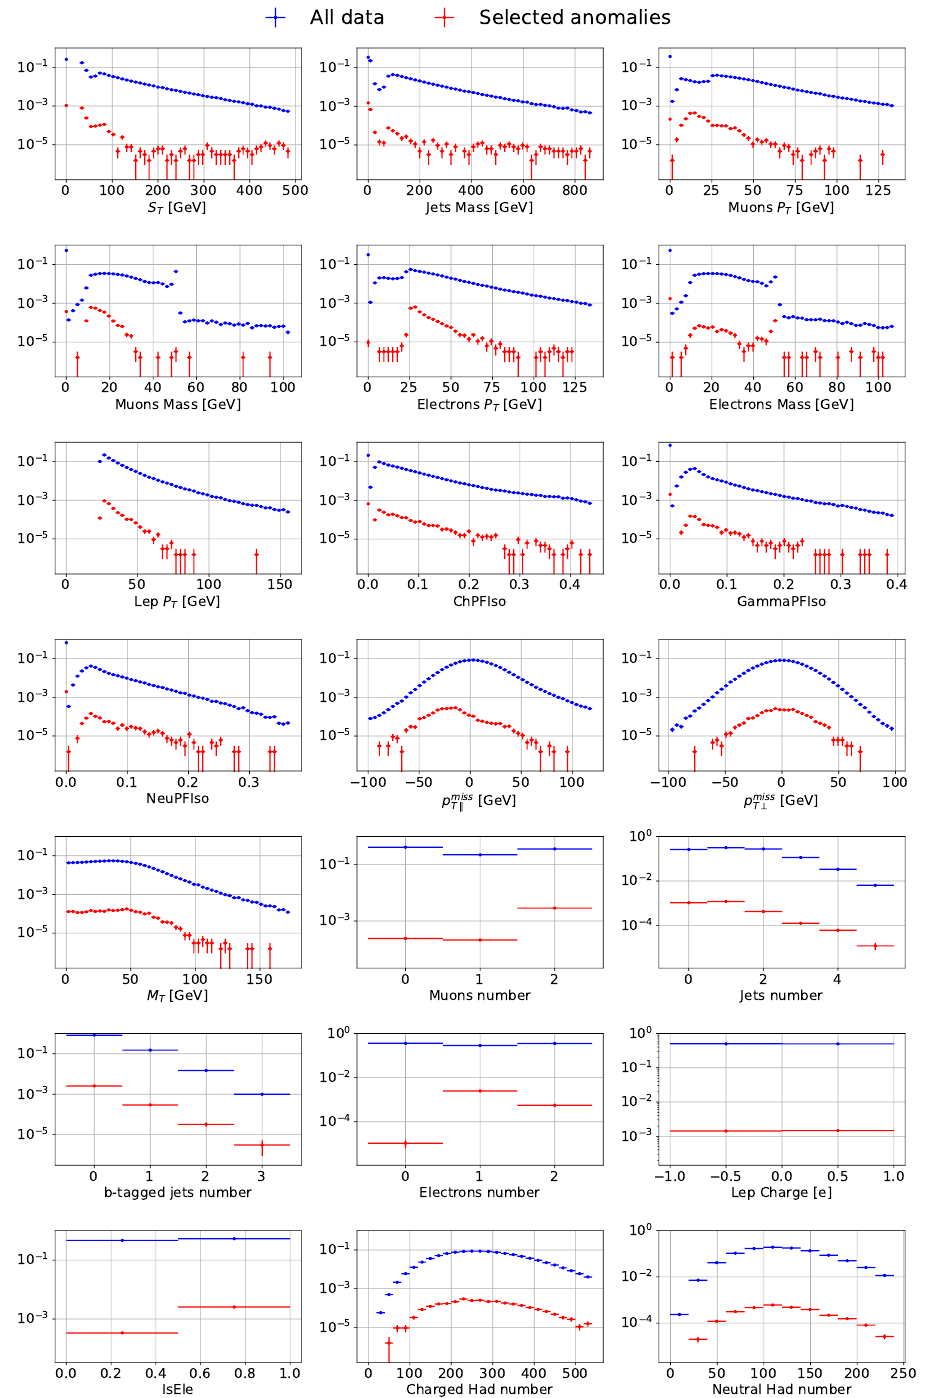
Figure 9 . Comparison between the distribution of the 21 HLF distribution for A ! 4 ‘ full dataset (blue) and A ! 4 ‘ events selected by applying the Loss reco threshold (red). The selected events are not trivially sampled from the tail.